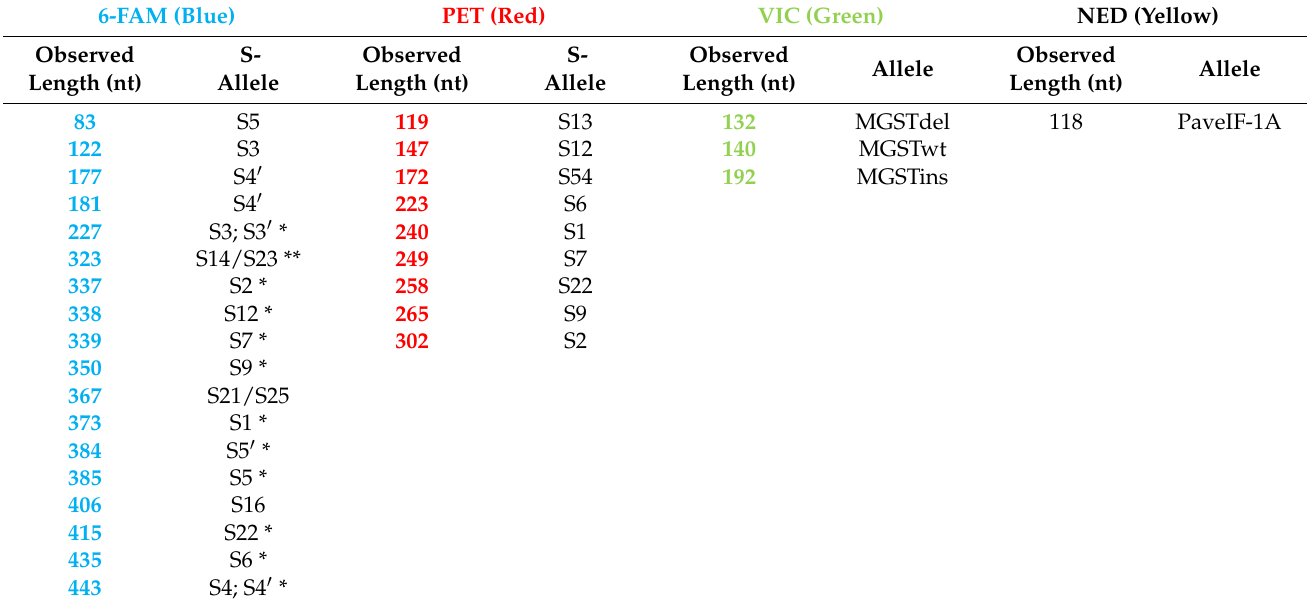
Table 3. A fragment association with a particular MGST-, S-allele, and the PaveIF-1A control. * Confirmation of the particular S-allele by another fragment. ** According to the alignment of GenBank sequences DQ266445 for S14 and AY259114 for S23, there are only three nucleotides different, and all of them lie in introns. As the S-RNase protein will be the same for both S-alleles, distinguishing these alleles was not a priority of this